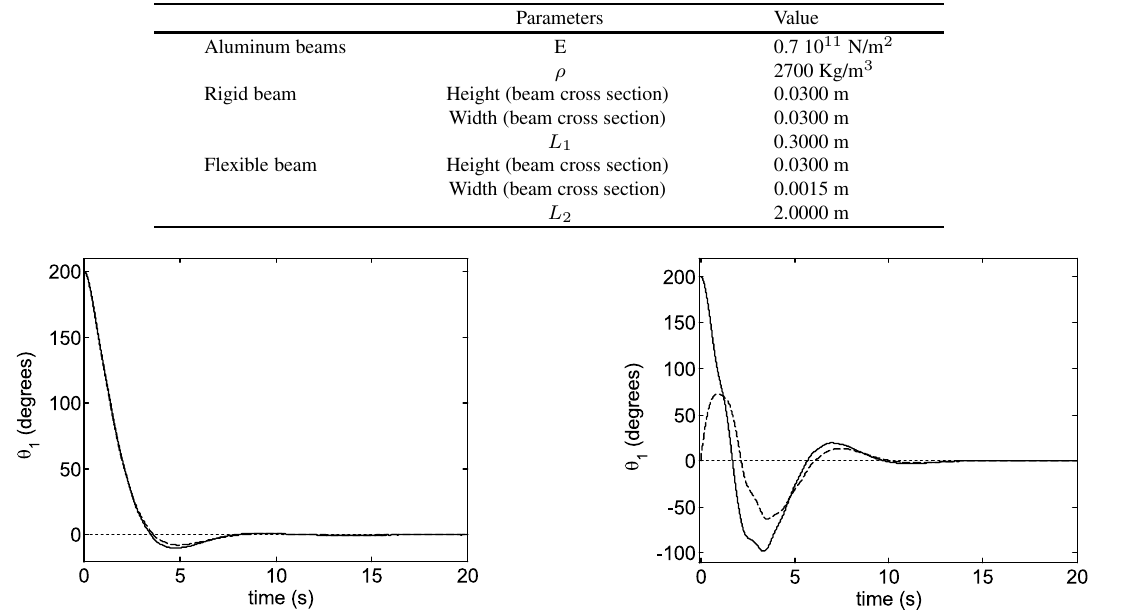
Fig. 3. Estimated (- - -) and “real” (—) behavior of measured vari- able θ 1 considering same initial conditions.